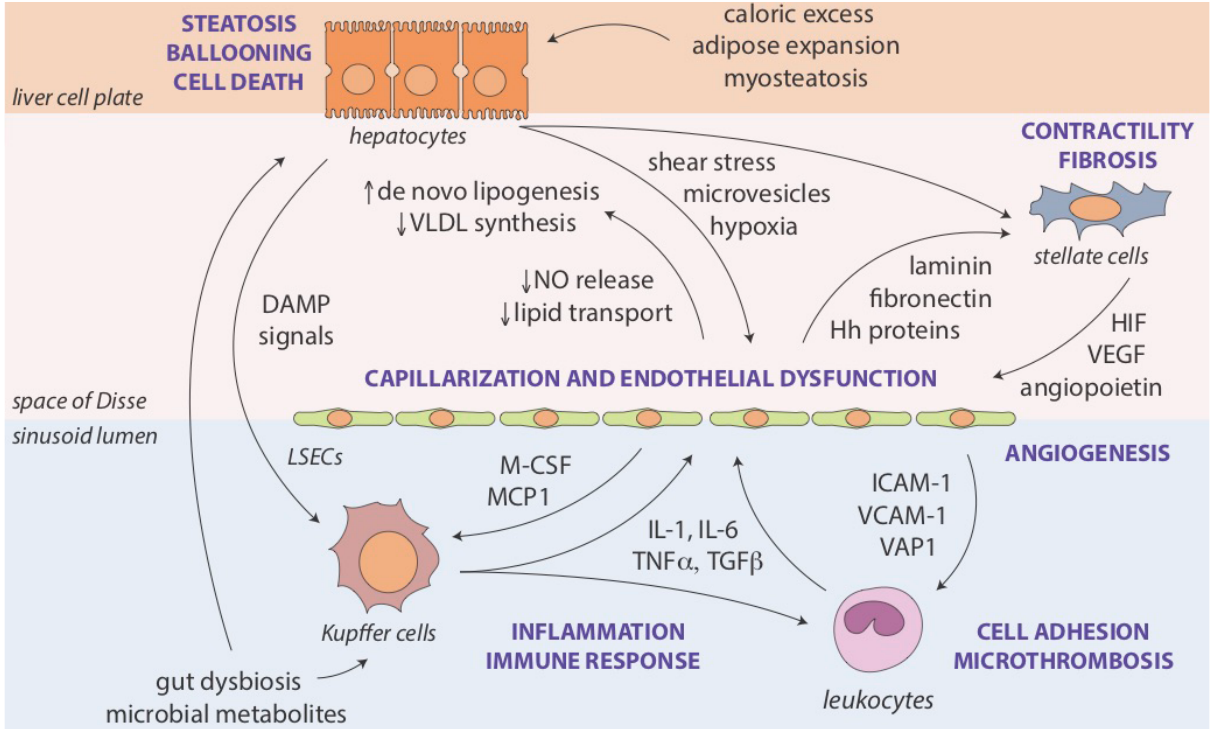
Figure 2. Molecular and cellular pathways of sinusoidal dysfunction in NAFLD. Key mechanisms and intermediate disease pathophenotypes implicated in the development of portal hypertension in NAFLD. Steatosis as an initial feature of the metabolic syndrome in the liver results from interactions with extrahepatic sites affected by caloric excess and insulin resistance (adipose tissue expansion [49], myosteatosis [50] and gut dysbiosis [51, 52]), as well as from endogenous lipid synthesis enhanced by structural (e.g., capillarization) and functional (e.g., impaired NO release) changes in LSECs [42]. Lipotoxicity may lead to ballooning injury of hepatocytes, contributing further to shear stress, cellular hypoxia, endothelial dysfunction, and activation of Kupffer cells and stellate cells [53, 54]. Augmented inflammatory and immune responses include the recruitment additional cellular components of innate immunity (e.g., polymorphonuclear leukocytes) promoting adhesion and microthrombosis [55]. Loss of NO- mediated tonic control by hepatocytes and LSECs combined with an abundance of activating mediators stimulates contractility and transformation of stellate cells into myofibroblasts leading to fibrosis and angiogenesis, further narrowing the sinusoidal space and increasing intrahepatic vascular resistance [41, 46]. Hh: Hedgehog; HIF: hypoxia-inducible factor; ICAM: intercellular adhesion molecule; IL: interleukin; M-CSF: macrophage colony-stimulating factor; MCP: monocyte chemoattractant protein; TGF: transforming growth factor-beta; TNF: tumor necrosis factor-alpha; VAP: vascular adhesion protein; VCAM: vascular cell adhesion molecule; VEGF: vascular endothelial growth factor; VLDL: very low-density